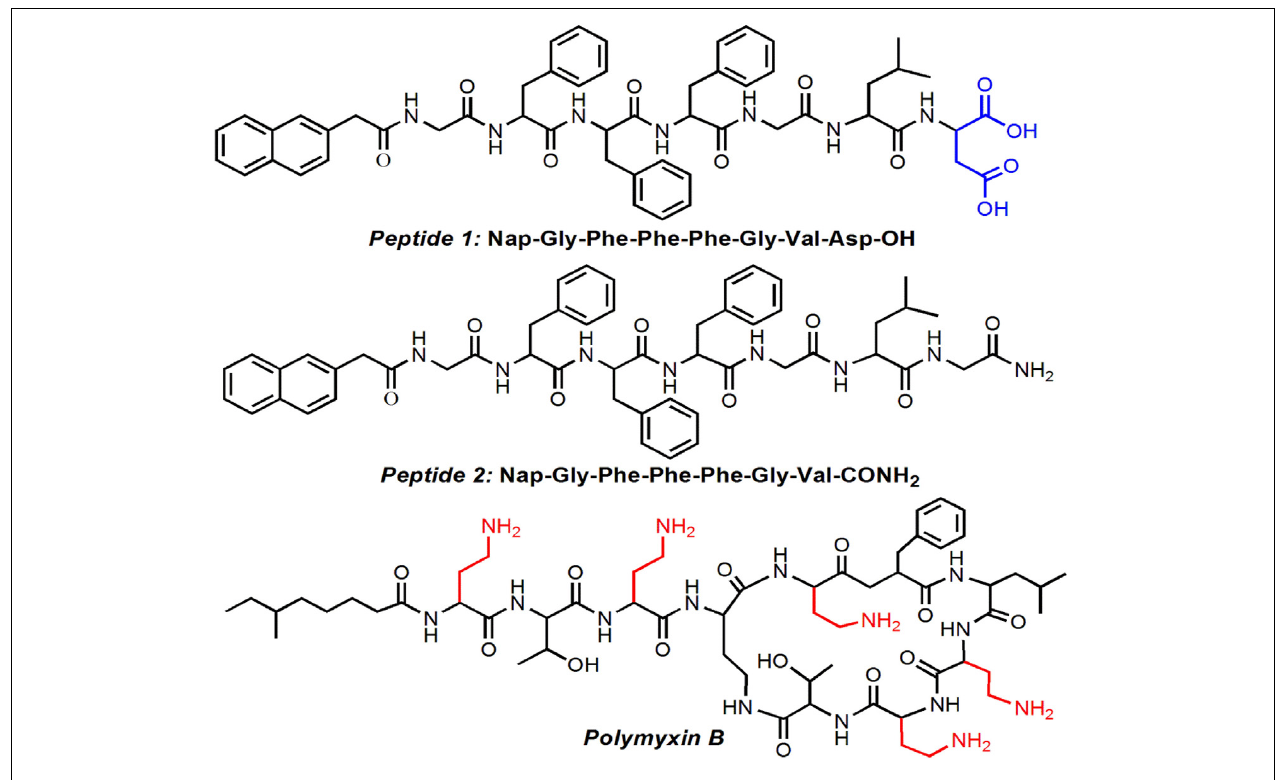
FIGURE 1 | Chemical structures of the amphiphilic peptides and polymyxin